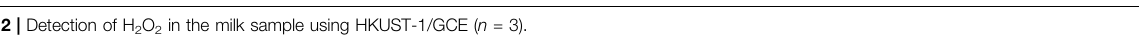
TABLE 2 | Detection of H 2 O 2 in the milk sample using HKUST-1/GCE ( n (cid:2) 3).